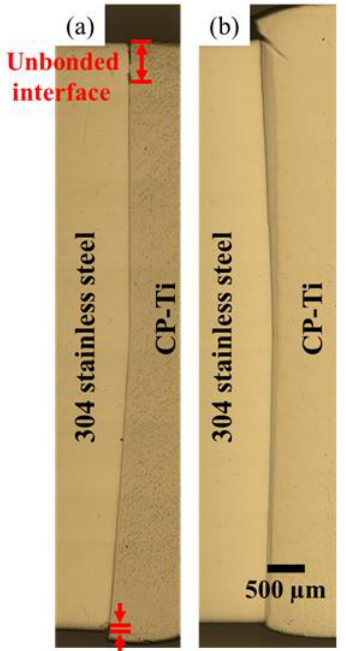
Figure 5. Optical micrographs of the 304 stainless steel/CP-Ti joint at an axial pressure of 30 MPa, a bonding time of 15 s, and a bonding temperature of ( a ) 880 °C and ( b ) 1140 °C.